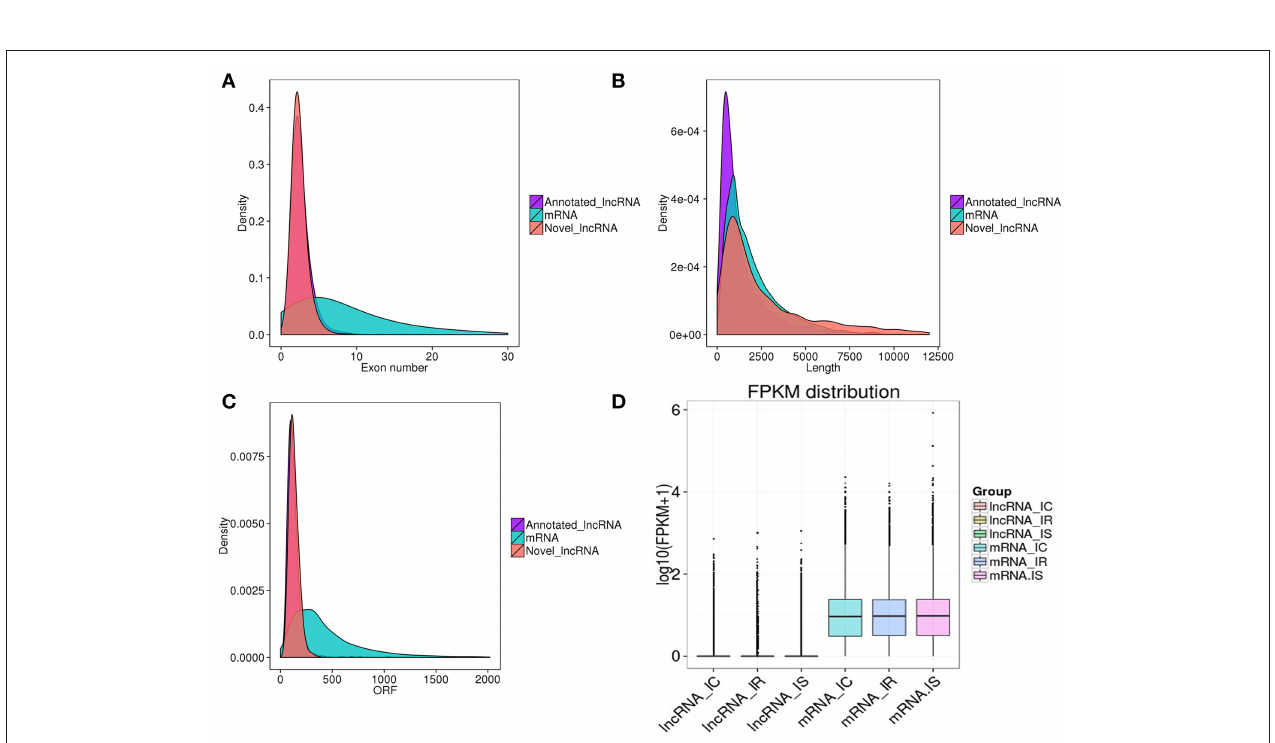
FIGURE 3 | Genomic characteristic of lncRNAs and mRNAs in piglet ileums. (A) Exon number distribution of lncRNAs and mRNAs; (B) Length distribution of 1,850 annotated lncRNAs (purple), 25,491 mRNAs (green), and 1,890 putative novel lncRNAs (red); (C) ORF length distribution of lncRNAs and mRNAs; (D) Box plots showing the expression levels (log 10 FPKM) of lncRNAs and mRNAs in IR, IS, and IC groups.